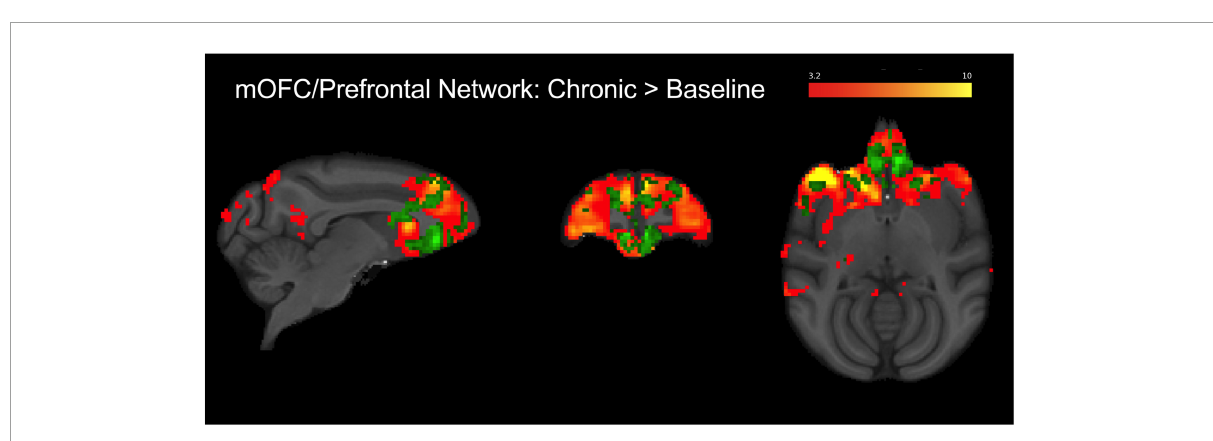
FIGURE4 Group level ( N = 4) fronto-cortical resting-state network spatial maps encompassing the mOFC, prefrontal cortex, and anterior cingulate (red-yellow). Green overlay shows regions identified using dual regression with greater connectivity during chronic AM2389 treatment relative to baseline ( p < 0.05). There were no statistically significant differences between acute drug scan or discontinuation and baseline. See text for additional